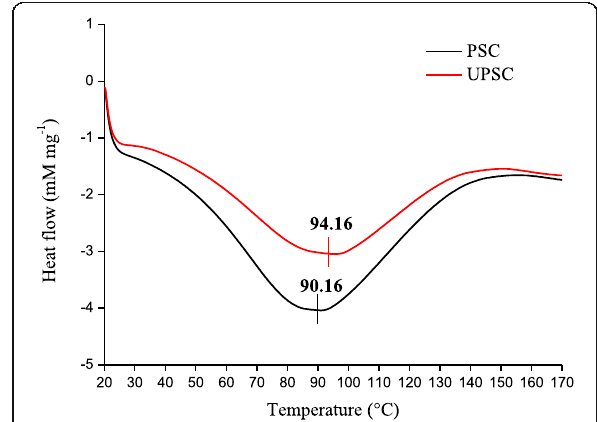
Fig. 5 Differential scanning calorimetry (DSC) thermograms of PSC and UPSC from chicken